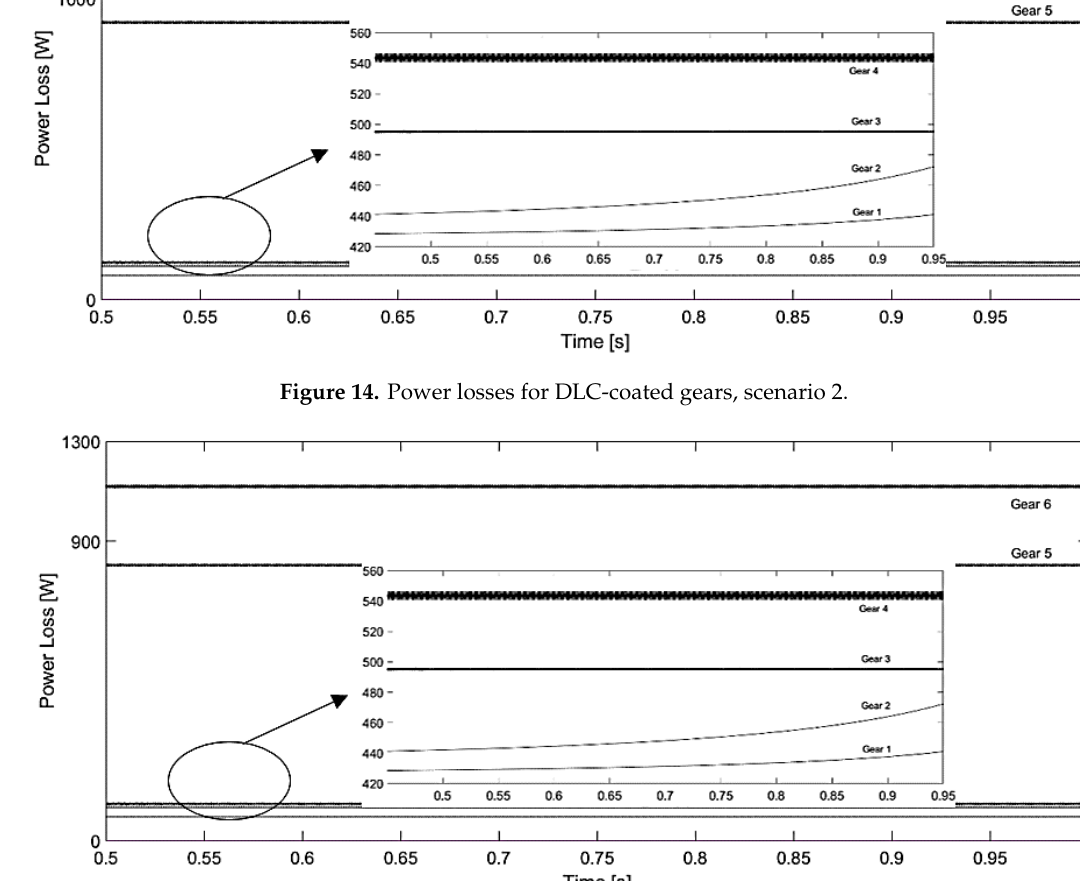
Figure 15. Power losses for WCC-coated gears, scenario 2.